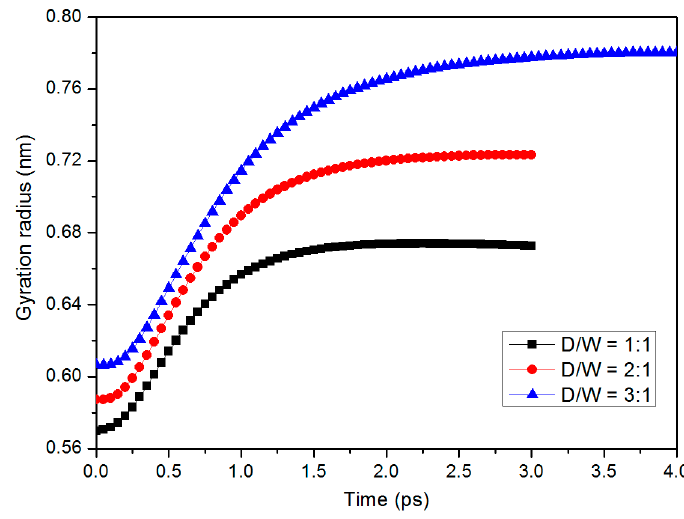
Figure 3. Gyration radii of polypropylene (PP) chain during the demolding process with different depth-to-width ratios (D/W).